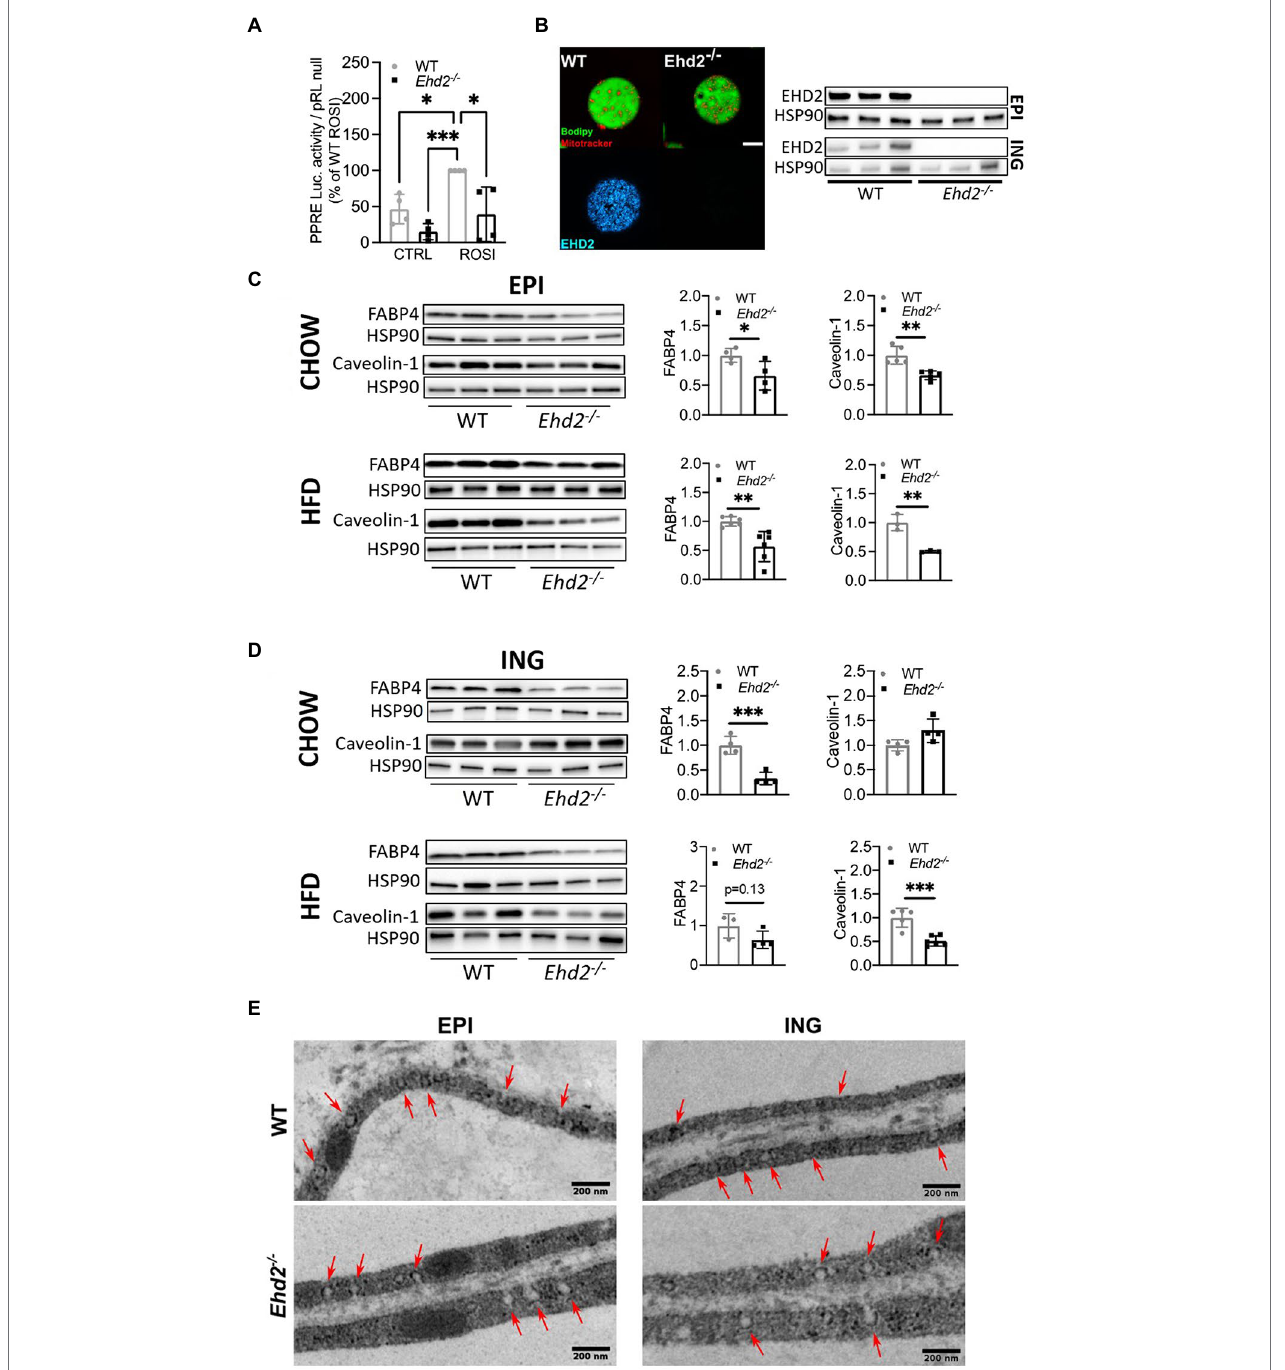
FIGURE 4 | PPAR γ activity, FABP4 expression, and caveolin-1 in adipocytes from Ehd2 − / − and WT mice. (A) PPAR γ activity in primary isolated EPI adipocytes from chow-fed Ehd2 − / − and WT mice, non-stimulated or stimulated with rosiglitazone (ROSI) for 24 h using transfection and dual luciferase assay. Data were normalized to Renilla reporter (pRLnull), and expressed as percentage of ROSI WT ( n = 4). (B) Left panel: Confocal image of primary EPI adipocytes from WT and Edh2 − / − mice stained for lipids (bodipy, green), mitochondria (Mitotracker, red), and EHD2 (antibody, blue), scale bar = 20 μ m. Right panel: Western blot analysis of EHD2 expression in cell lysates of primary adipocytes isolated from EPI and ING adipose tissue. (C) Representative western blots and quantification of total protein levels of FABP4 and caveolin-1 from primary adipocyte lysates from EPI adipose tissue from chow or HFD-fed mice. HSP90 was used as loading control, n = 3-6/group . (D) Same as in (C) with lysates from ING adipose tissue. (E) Electron micrographs showing the structure and distribution of caveolae at the adipocyte cell membrane in EPI and ING tissue from WT and Ehd2 − / − animals. Arrows show clearly discernible caveolae. Scale bar = 200 nm. Data in (A,C,D) are presented as mean ± SD, and * p < 0.05, ** p < 0.01 and *** p < 0.001 were calculated using one-way ANOVA, Tukey’s post hoc test (A) , and unpaired two-tailed Student’s t -test (C,D)